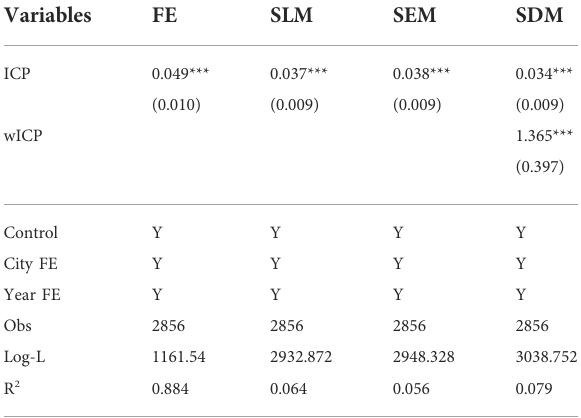
TABLE 9 Re-estimation of different dependent variable.